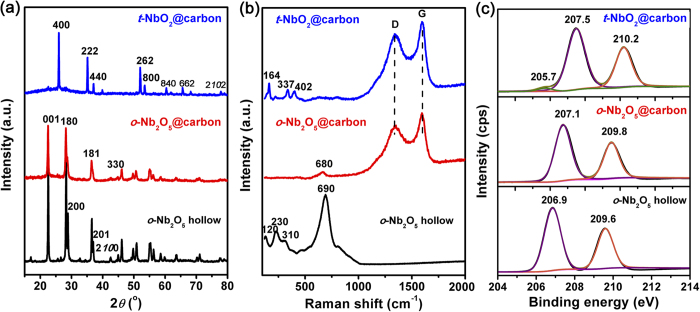
(a) XRD patterns, (b) Raman spectra and (c) high-resolution Nb3d XPS spectrum of o-Nb2O5 hollow microspheres, t-NbO2@carbon core-shell microspheres and o-Nb2O5@carbon core-shell microspheres.